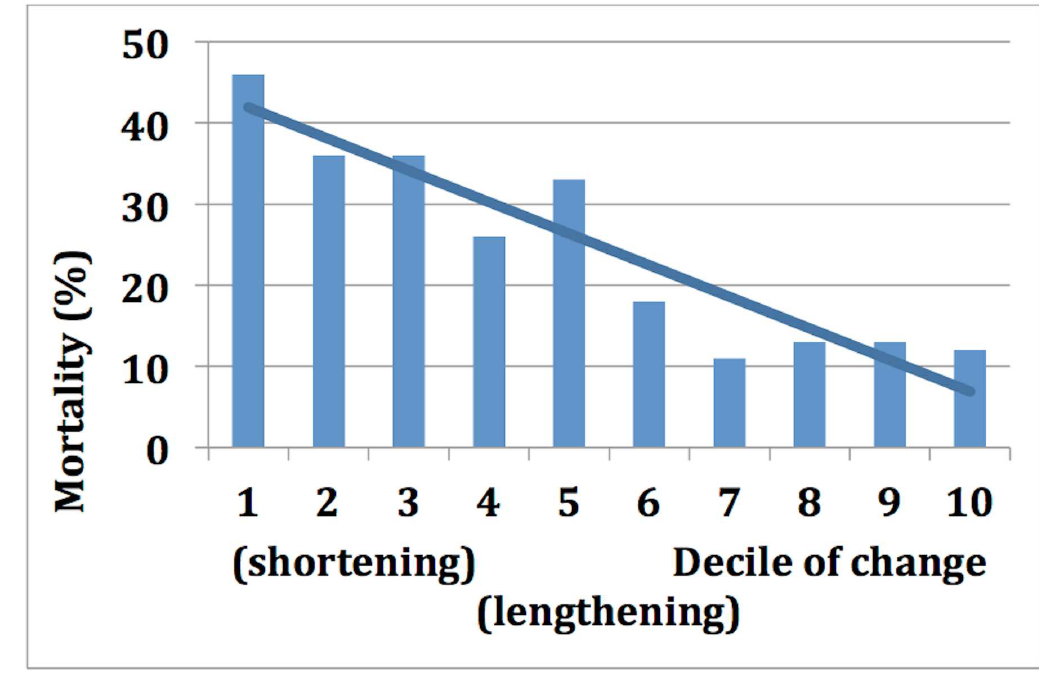
Fig 1. Mortality by decile of 5-year change in telomere length (p for trend < 0.001).